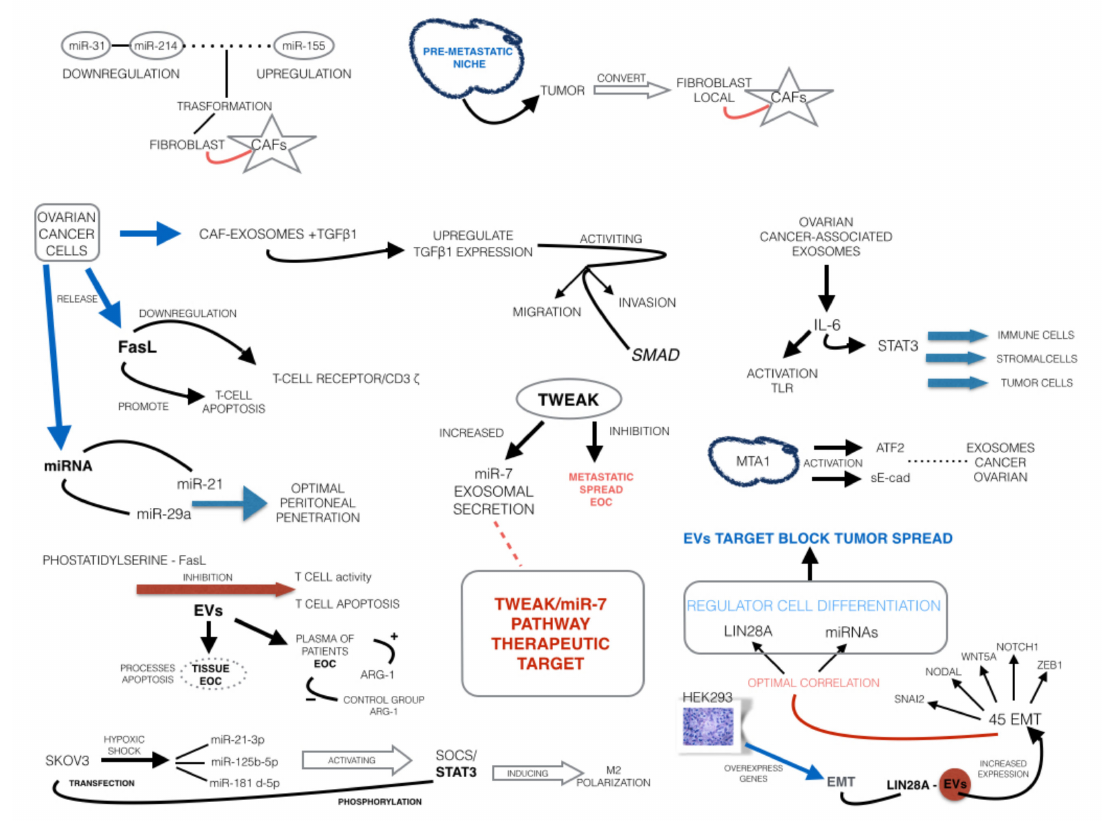
Figure 1. Extracellular vesicles and miRNAs as therapeutic targets in epithelial ovarian cancer